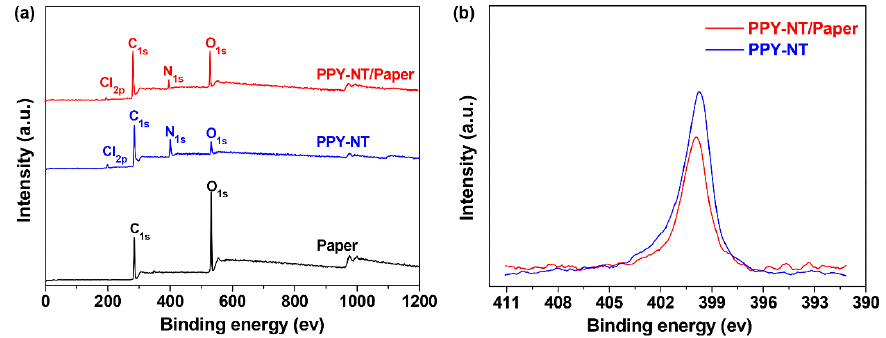
Figure 4. ( a ) XPS spectra of wide region spectroscopy of paper, PPy–NTs, and PPy–NT/paper composite film; ( b ) XPS spectra of N 1S of PPy–NTs and PPy–NT/paper composite film.